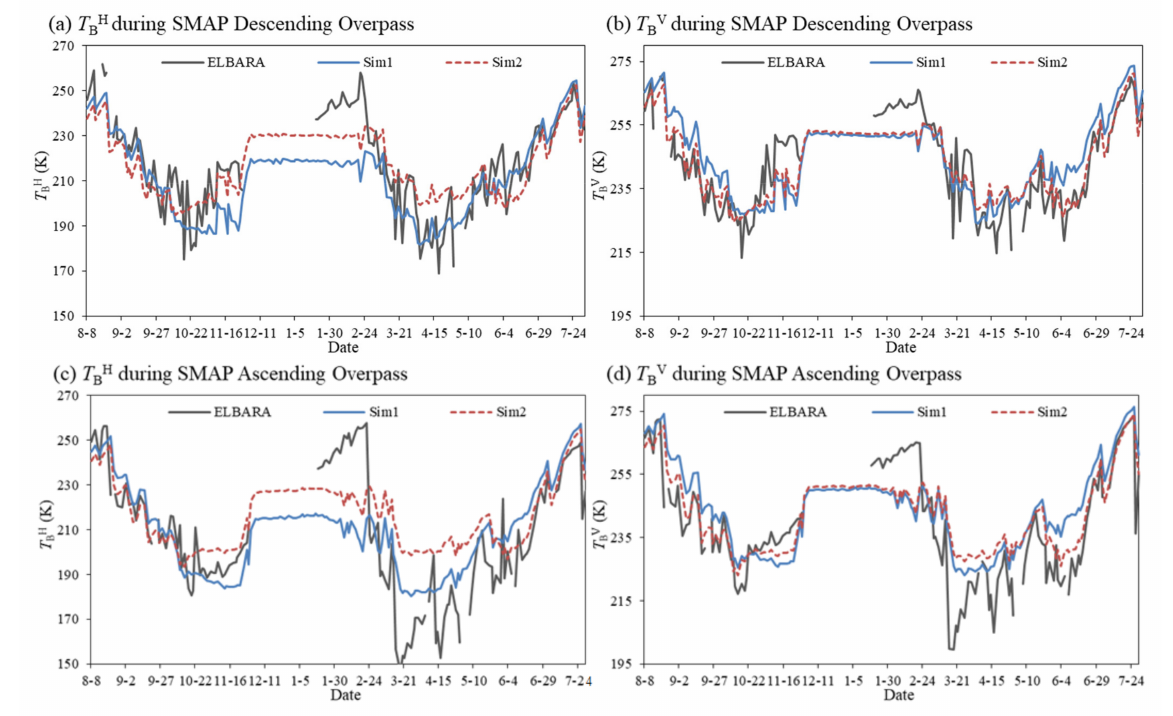
Figure 7. Time series of the ELBARA-III ( a , c ) T BH and ( b , d ) T BV measurements and simulations performed for the ELBARA-III footprint during the SMAP descending ( a , b ) and ascending ( c , d ) over- passes between August 2016 and July 2017. Sim1: two-stream emission model configured with SMAP parameterization; Sim2: Zheng’s parameterization. Table 2. Error statistics estimated between the ELBARA-III measured and simulated T B p performed for the ELBARA-III footprint between August 2016 and July 2017 for the SMAP ascending